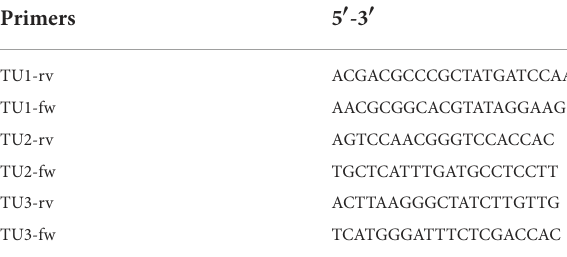
TABLE 1 Primers used in this